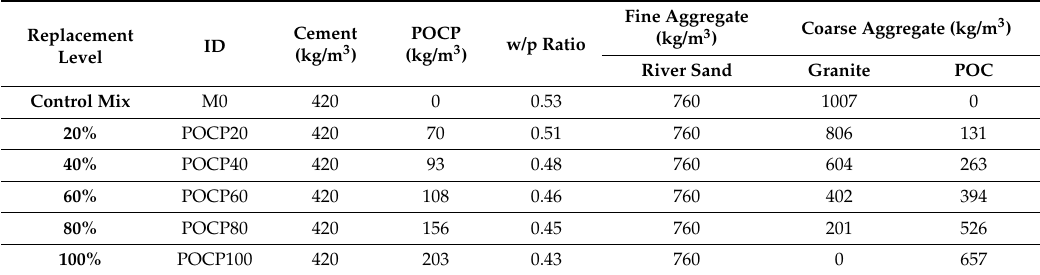
Table 4. Final mix proportion of POCP concrete.